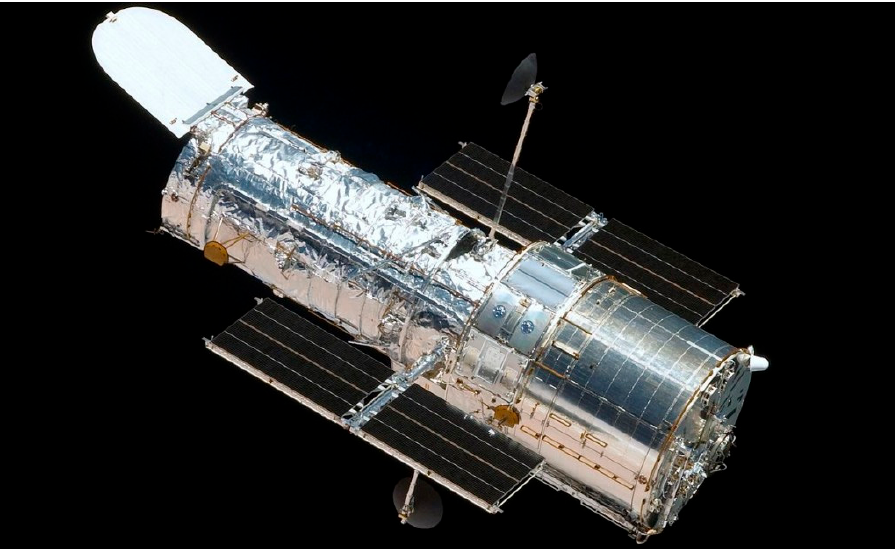
Figure 25. MLI Blanket Incorporated Satellite in Orbit [41].